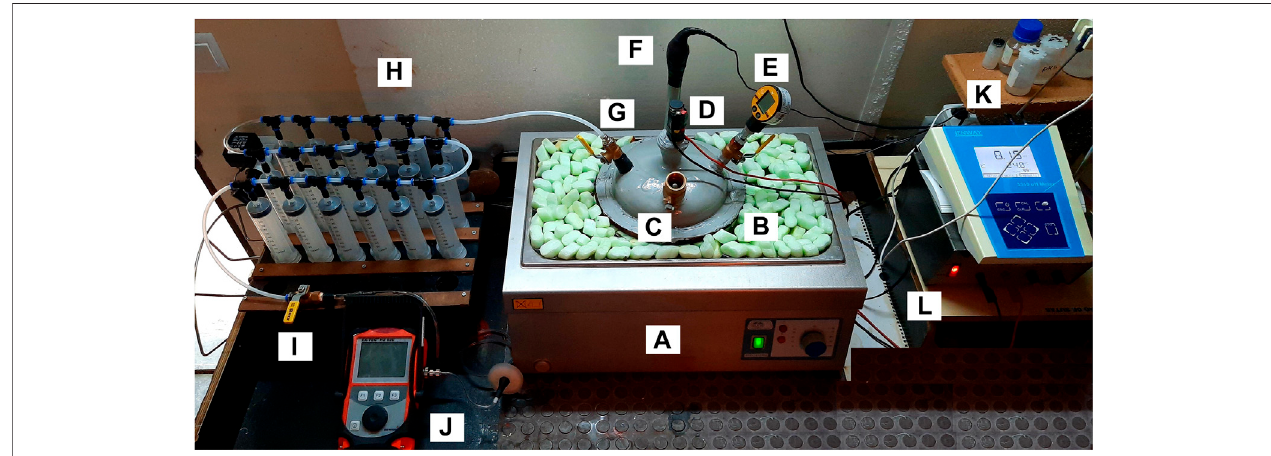
FIGURE3| Laboratorytestwithbiogasproductionandmeasurementsystem. (A) Hotwaterbath; (B) Anaerobicdigester; (C) Substratefeedinlet; (D) Motorofthe mechanical stirring system; (E) Manometer; (F) pH and redox potential measurement input; (G) Biogas outlet; (H) Measuring syringe battery; (I) System